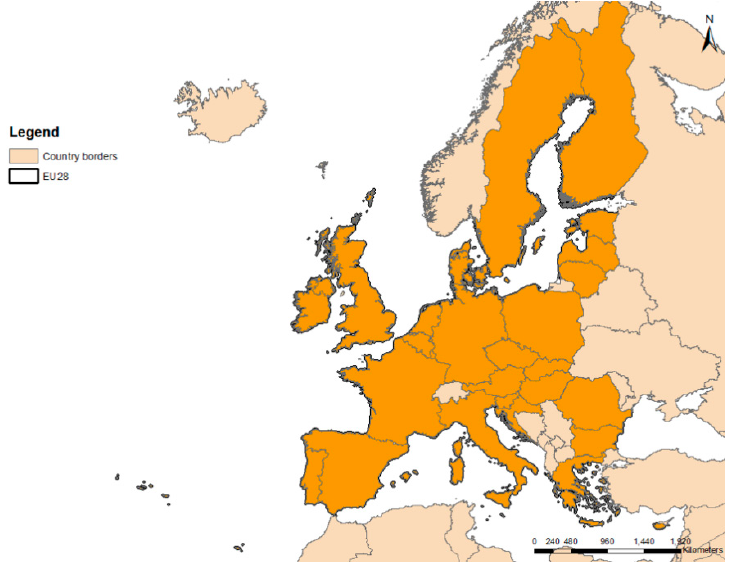
Figure 1. Map of EU28 territories considered in the study.